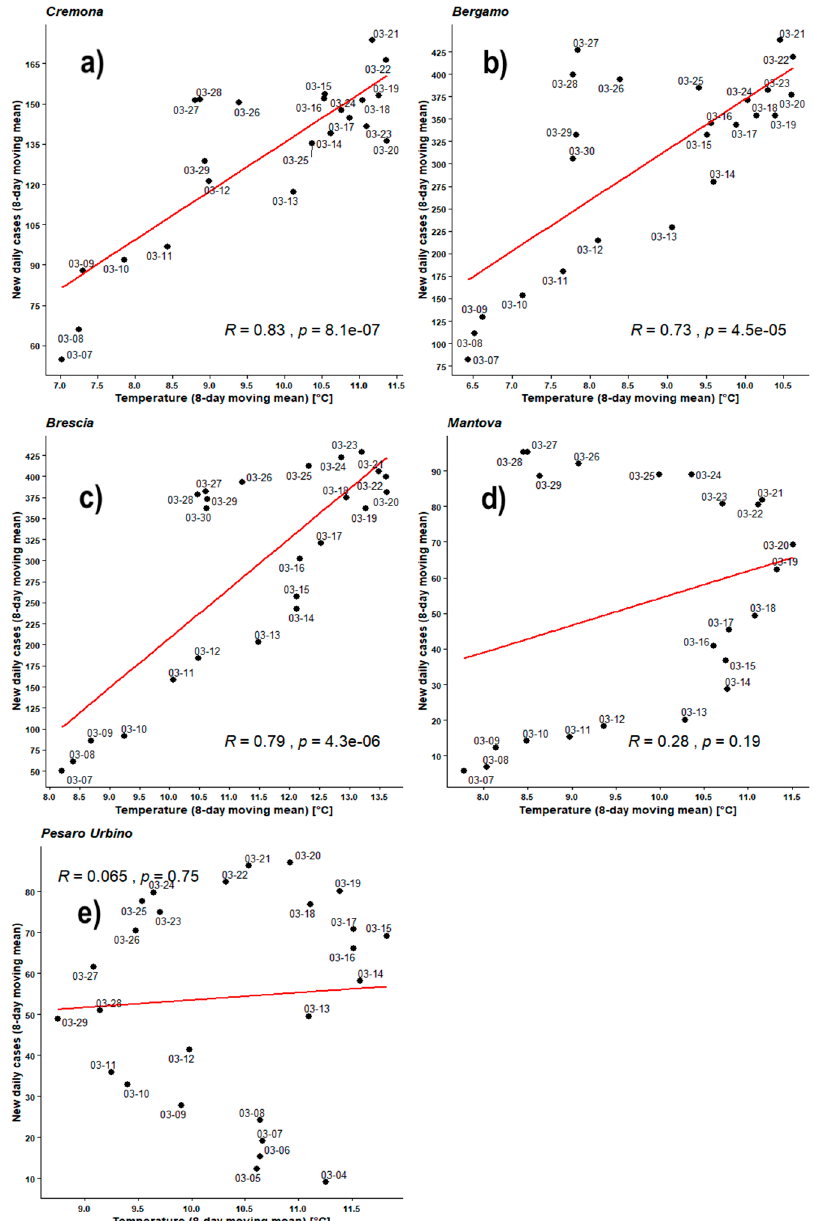
Figure 6. Scatter plot and linear regression for the 8-day moving means of new daily cases of COVID-19 against outdoor temperatures for five Italian provinces: ( a ) Cremona, ( b ) Bergamo, ( c ) Brescia, ( d ) Mantova, ( e ) Pesaro Urbino. Labels report, in MM-DD format, the last day of the moving means. Pearson correlation coe ffi cient is reported as ‘R’ while probability value is reported as ‘ p